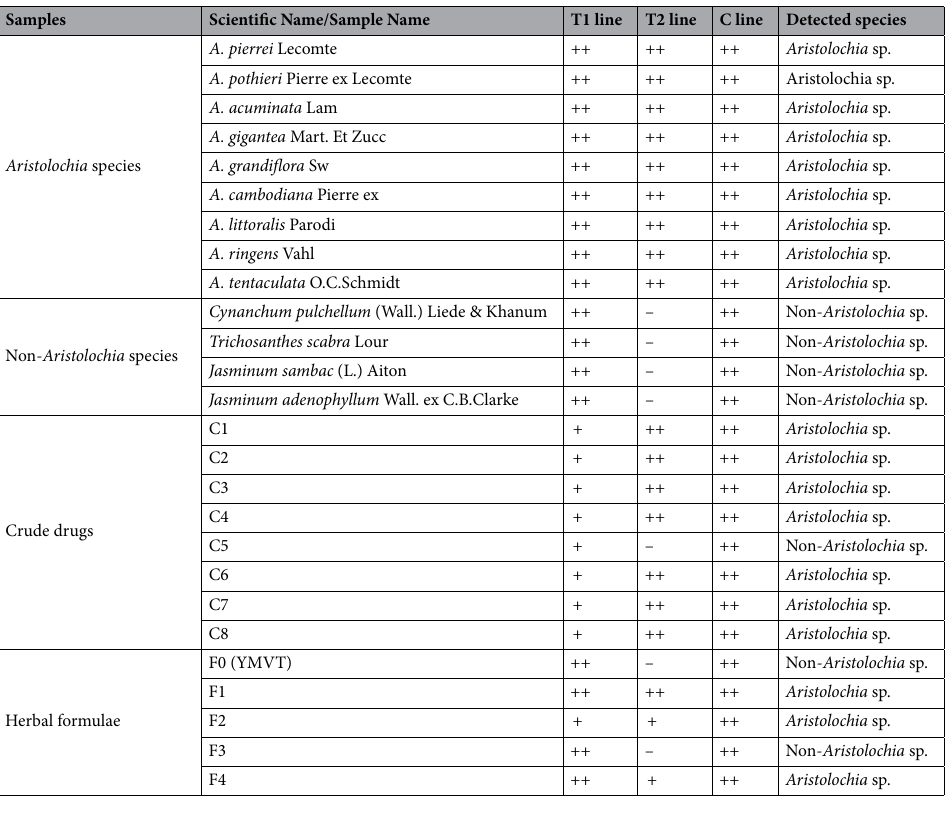
Table 2. Detection results of the tested samples by the PCR-LFA. Authentic Aristolochia spp. and selected plants were challenged with the PCR-LFA method. ++: clearly pink color. + : faint pink color. –: coloration was not